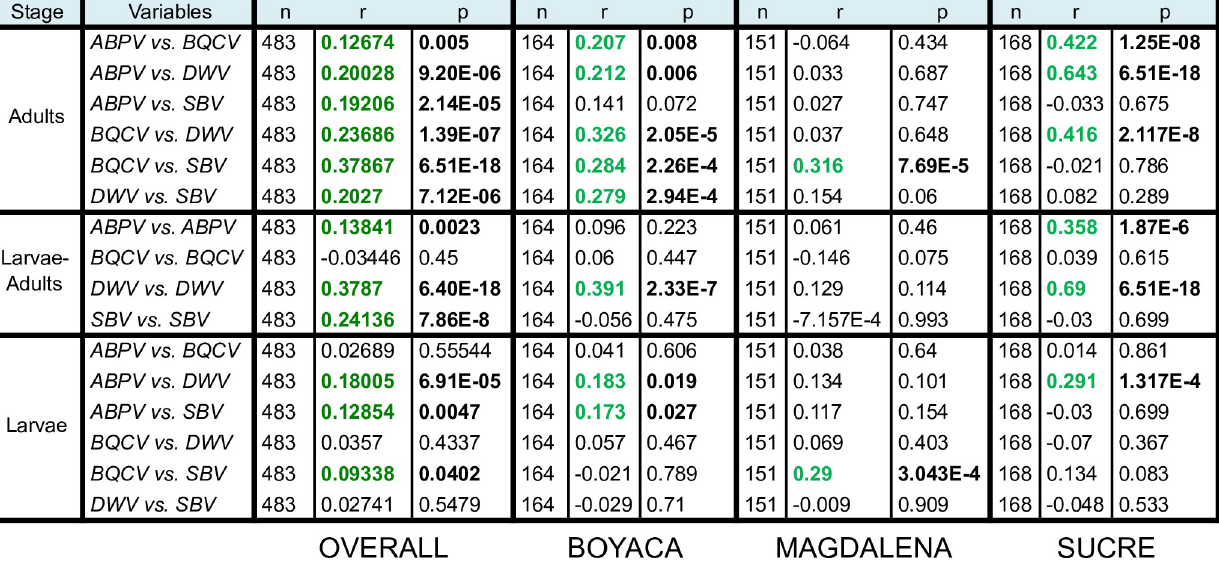
PLOS ONE | https://doi.org/10.1371/journal.pone.0244906 May 20,